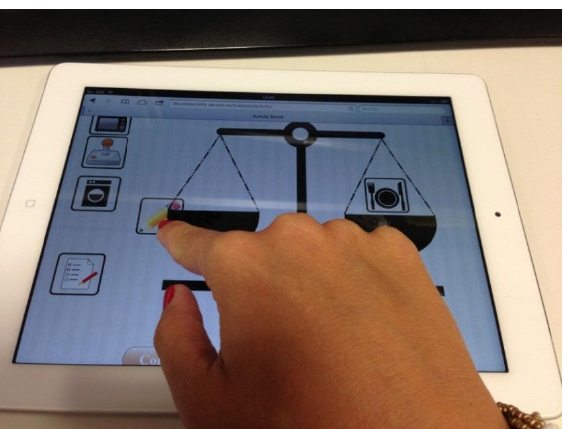
Figure 7. Online tool using a tablet